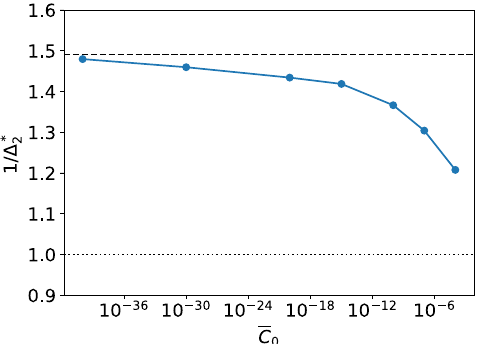
0 . 9 , with p ¼ ¯ C , ranging from 10 − 40 to FIG. 16. Phase diagram of the p ¼ 3 model, where we compare p ffiffiffiffiffiffiffiffiffiffiffi ≈ 1 . 491 following 2 = Δ the threshold of the Langevin hard region using different values p ¯ C 0 ¼ 10 − 40 , of the initial conditions, respectively: green circles ¯ ¯ C 0 ¼ 10 − 30 , red circles C 0 ¼ 10 − 20 yellow circles